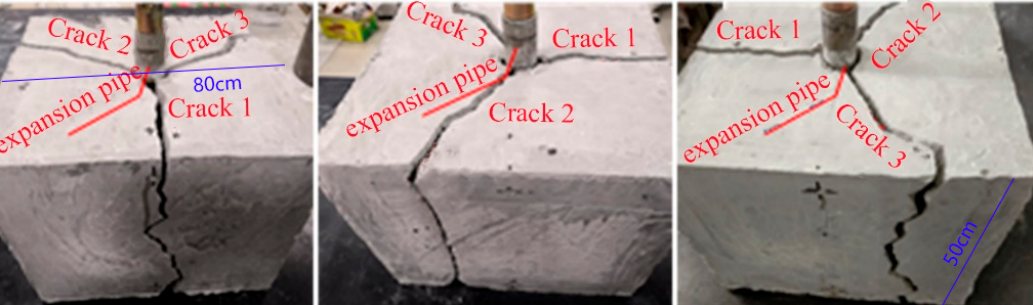
Figure 13. Unconstrained crack propagation survey.